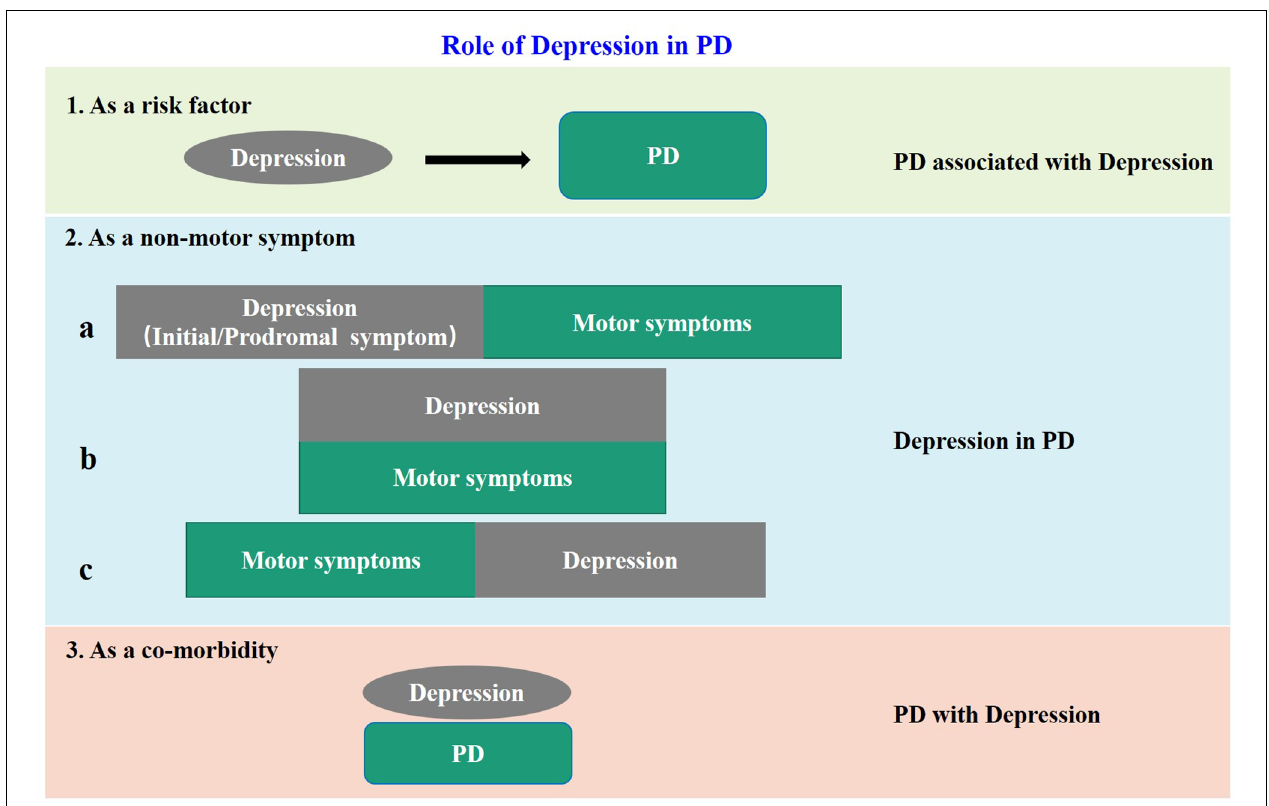
FIGURE 1 | The model diagram of the relationship between depression and PD. In case 1, depression is a risk factor for PD; in case 2, depression is a non-motor symptom of PD, and there are three sub cases, that is, it appears before motor symptoms as a prodromal symptom: (a) occurs simultaneously with motor symptoms; (b) and appears after motor symptoms; and (c) in case 3, it appears as an independent disease and comorbidity of